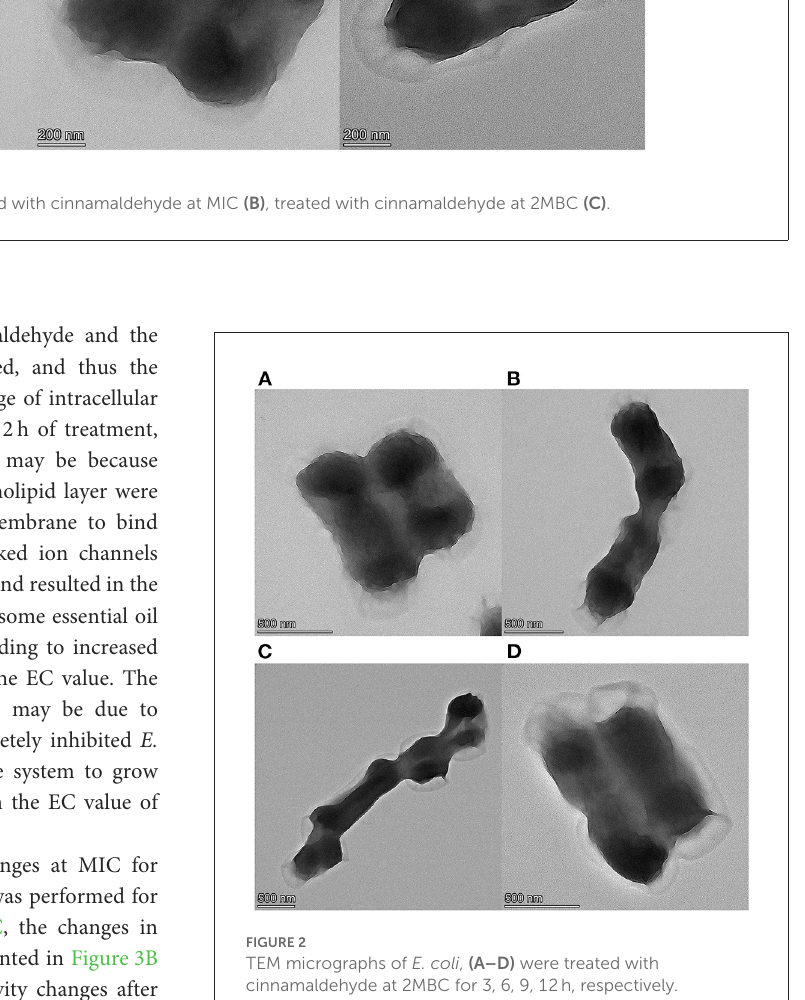
different cell membrane permeabilities of E. coli at different time